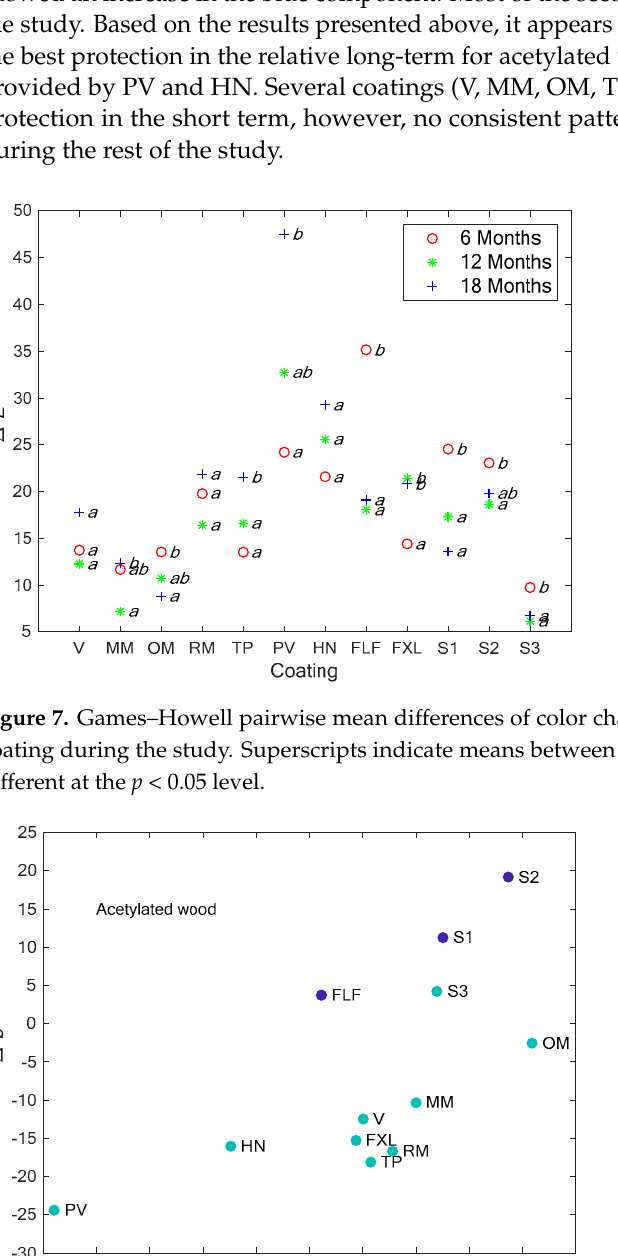
Figure 8. Cluster results plotted on the Δ L * and Δ b * axes. The cluster solution utilizes linkage dis- tances calculated with MANOVA using 18-month Δ L *, Δ a *, and Δ b * values for acetylated wood. Acetylated wood surfaces treated with PV and S3 experienced progressive weather- ing and mildew growth over the 18 month exposure (Figures 9 and 10). Darkening of wood surfaces appeared to be largely caused by mildew growth suggesting that these treatments had little effect on these ubiquitous fungi. In contrast, PV-treated acetylated radiata pine was colonized by mildew within the first 6 months of exposure and continued